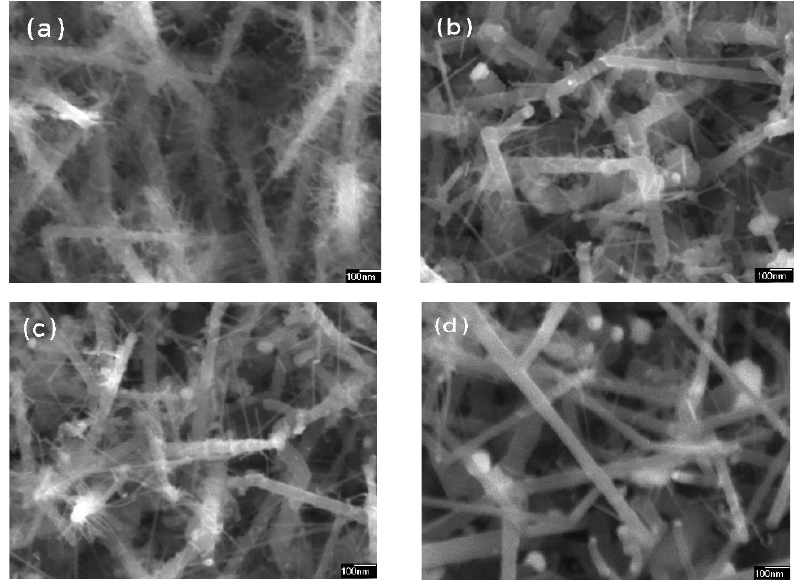
Figure 2. SiNTr synthesized by two Silane shots. The trunks’ growth temperature was ( a ) 555 ◦ C, ( b ) 545 ◦ C, ( c ) 535 ◦ C and ( d ) 520 ◦ C.